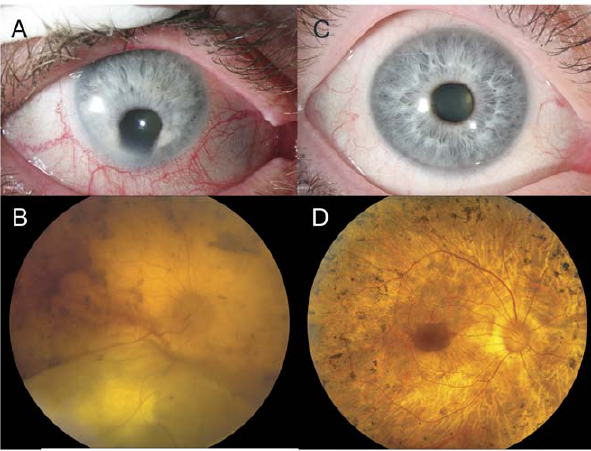
Figure 2. Ocular examination of affected patients IV- 2 at age 63 and IV-4 at age 55. Patient IV-2 exhibited anterior segment dysgenesis with a small cornea, inferiorly displaced pupil, and inferior coloboma of the iris with corneal limbal neovascularization (panel A). The fundus shows an inferior coloboma of the retina and choroid and severe chorioretinal atrophy (panel B). Patient IV-4 has normal anterior segments coloboma or other abnormalities (panel C). The fundus in both eyes was similar with widespread retinal degeneration comprising extensive peripheral retinal atrophy, ‘‘bone spicule’’ pigmentation throughout except for the central-most macula, and markedly attenuated retinal arterioles (panel D).